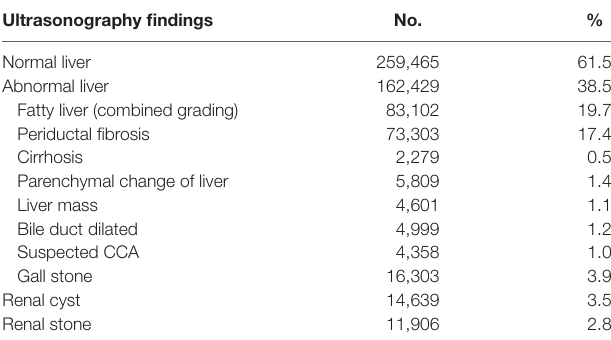
TABLe 2 | Number and percentage of ultrasonography diagnoses ( n =